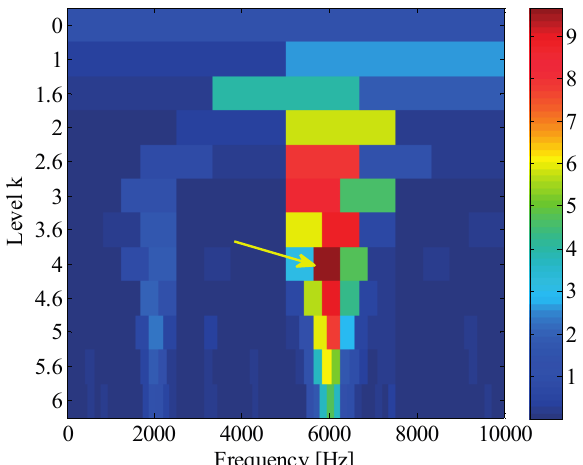
Figure 11. Kurtogram of simulated multi-fault signal.